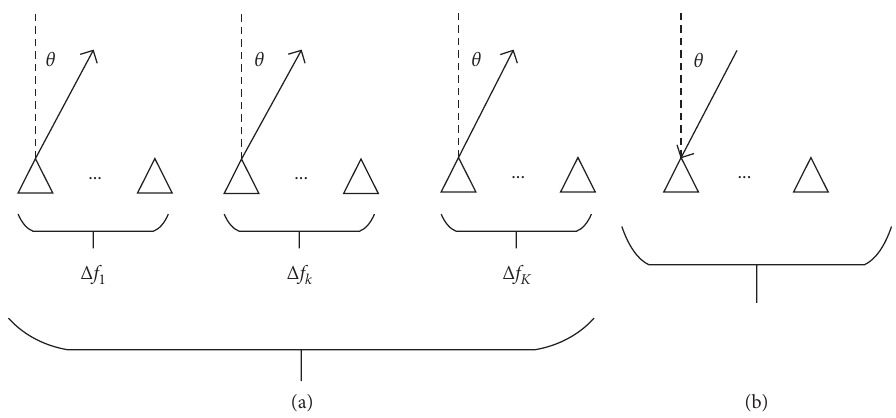
Figure 1: Transmitting subarrays monostatic FDA-MIMO radar system. (a) Transmitting array. (b) Receiving